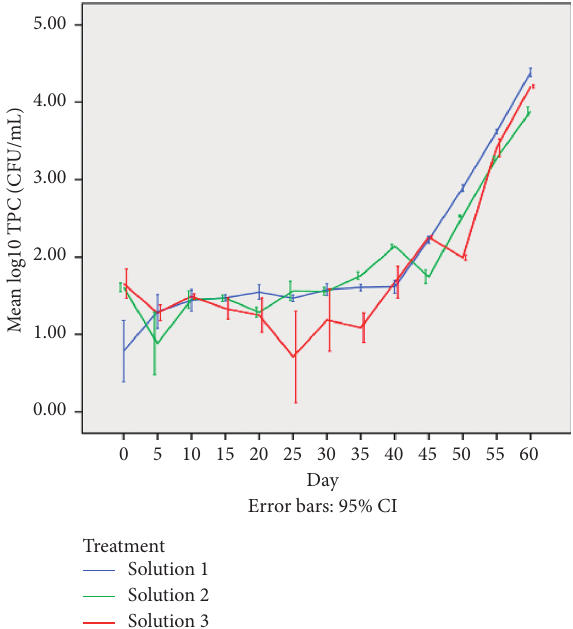
Figure 2: Changes (means ± SD) in the TPC of antimicrobial edible coating solutions: solution 1 (0.250 g/L Delvocid), solution 2 (0.275 g/L Delvocid), and solution 3 (0.300 g/L Delvocid) during the storage at 8 ° C and 85%